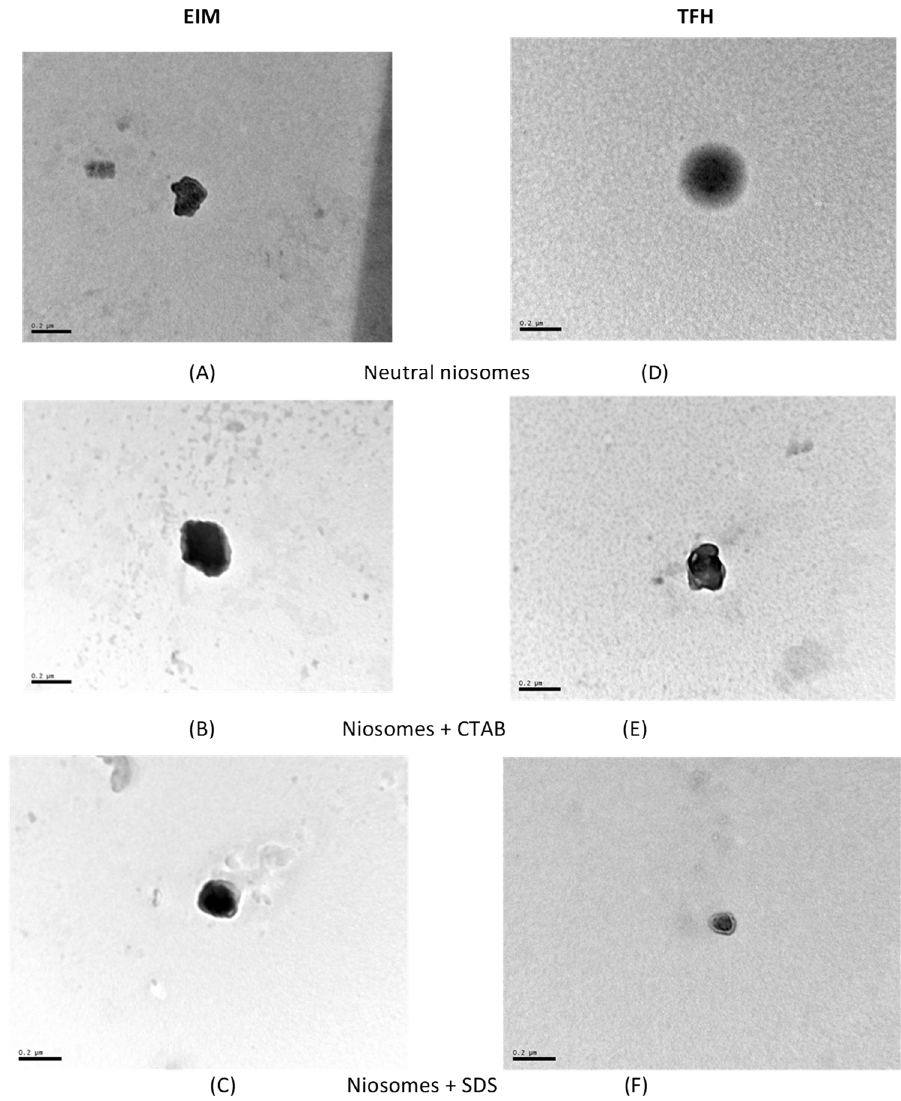
Figure 3. TEM images of vesicles prepared by ethanol injection (EIM) ( A – C ) and thin film (TFM) ( D – F ). Formulations: ( A , D ) niosomes, ( B , E ) niosomes with CTAB, and ( C , F ) niosomes with SDS.